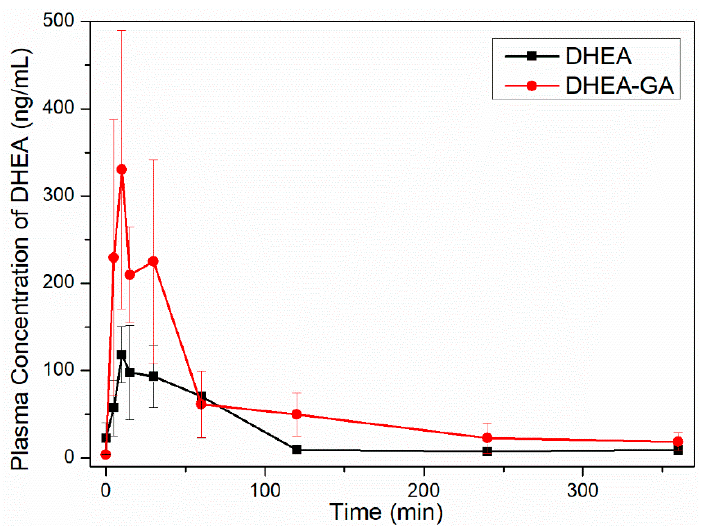
Figure 11. Plasma DHEA concentration versus time curves of DHEA and DHEA-GA in SD rats (male, n =